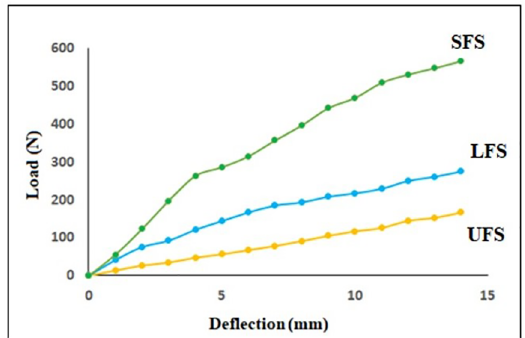
Figure 2. Strain rate of the composite springs